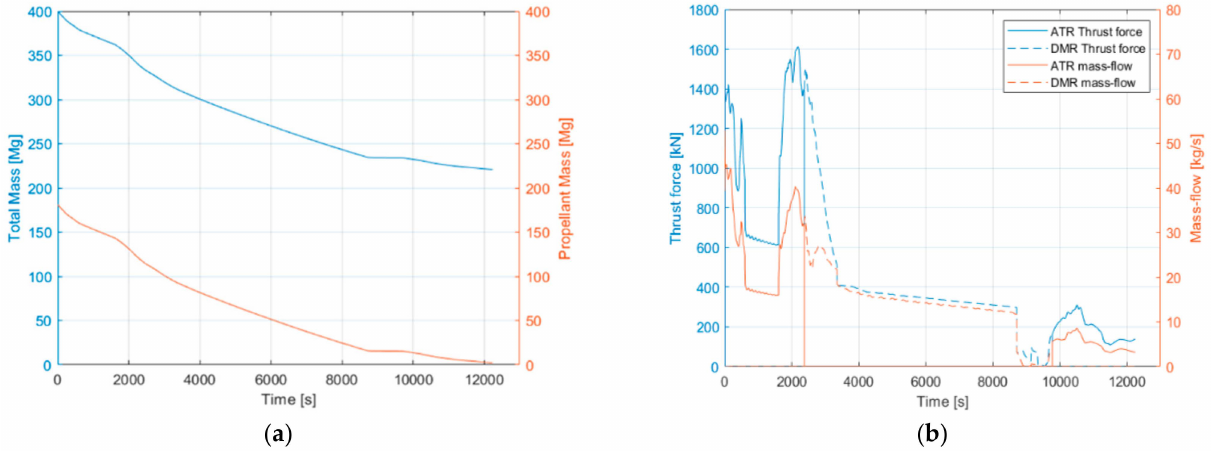
Figure 4. STRATOFLY MR3 propellant mass ( a ), engine thrust (total) and propellant mass flow ( b ) as function of time